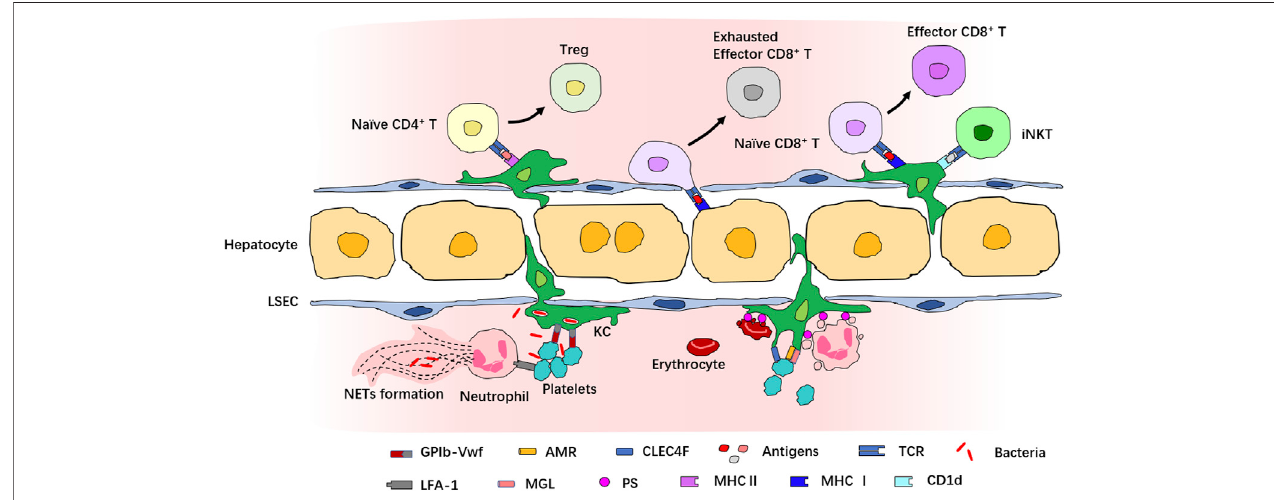
FIGURE3 | Interaction ofimmunecells inthe liver revealed by IVM. Multiple immunecells interact with each other in both physiological and pathological conditions in the liver. Many cells in the liver can act as antigen-presenting cells to interact with T cells. KCs express both MHC Ⅰ and MHC Ⅱ and many costimulatory molecules and present antigens to naive CD4 + or CD8 + T cells for their activation and priming. The antigen presentation to CD8 + T cells by KCs induces full differentiation to effector CD8 + T cells, while the antigen presentation to CD4 + T cells by KCs induces differentiation into Treg. Hepatocytes also present antigens to CD8 + T cells, but this leadstoexhaustionofCD8 + Tcells.KCsactivateiNKTcells via CD1d. Interaction amongKCs,neutrophils,andplateletsprovidesdefenseagainstbacteriainvasion,and neutrophil – platelet interaction is necessary for NET formation. In addition, KCs also recognize apoptotic cells and interact with senescent and apoptotic erythrocytes, platelets, and neutrophils for the clearance of dying immune